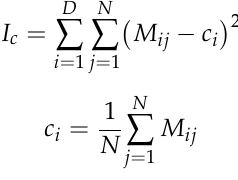
Figure 4. Comparison of the convergence behavior of MFO-SFR and well-known algorithms for CEC 2018 test functions with 30 and 50 dimensions.